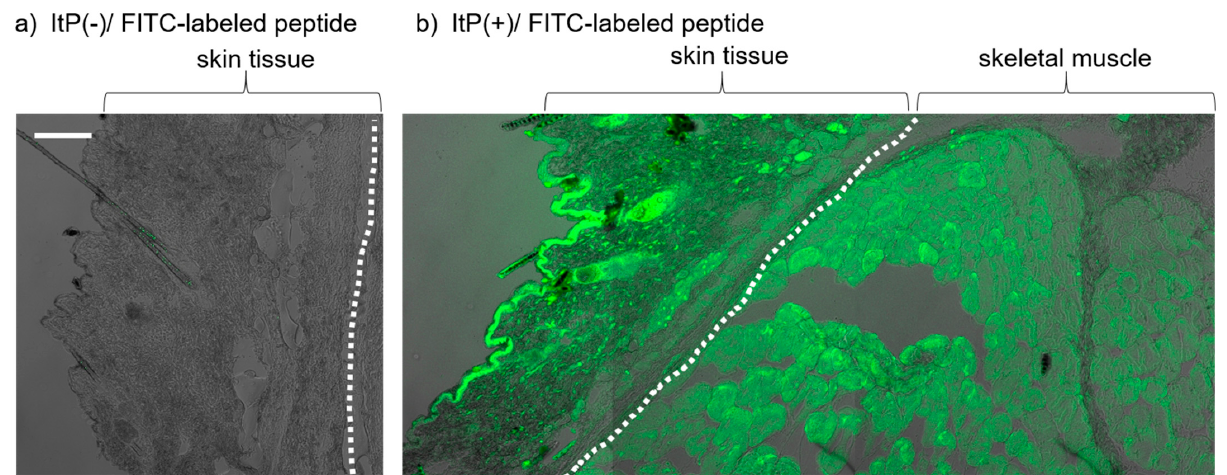
Figure 1. Intradermal and intramuscular distribution of fluorescently labeled myostatin inhibitory peptide after ItP: ( a ) Skin section treated with FITC-labeled peptide topical application without ItP. ( b ) A section containing skin and muscle after ItP of FITC-labeled peptide on the surface of the skin of mouse hind legs. The sections were observed by confocal laser scanning microscope 42 days after application. The white dotted line shows the border between skin and muscle. White bar = 100 μ m.